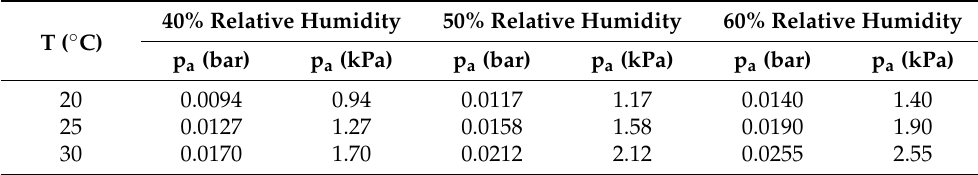
Table 14. Saturation pressure at ambient air dew point p a .